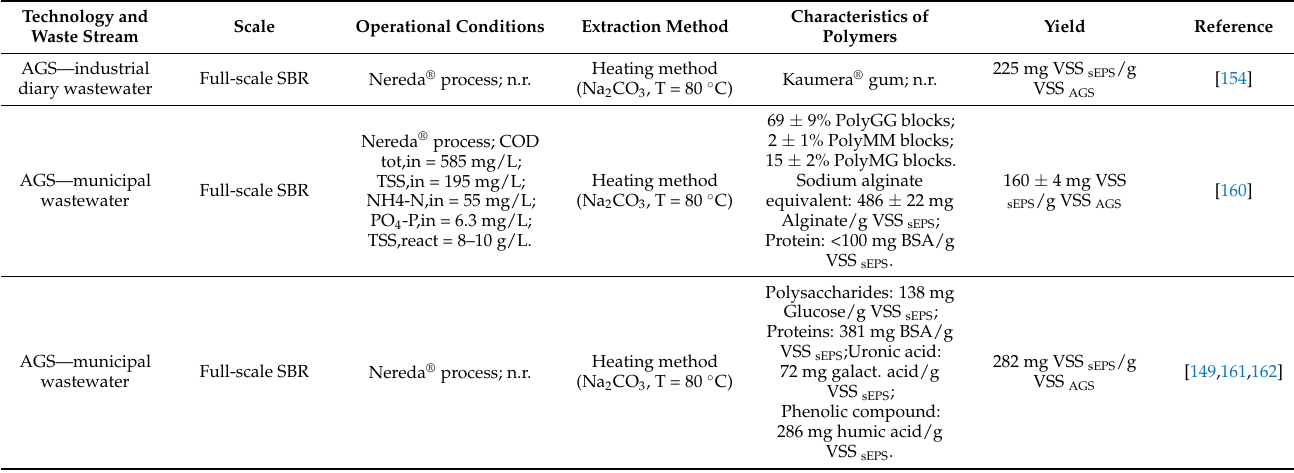
Table 11. EPS recovery from granular sludge collected at pilot- and full-scale